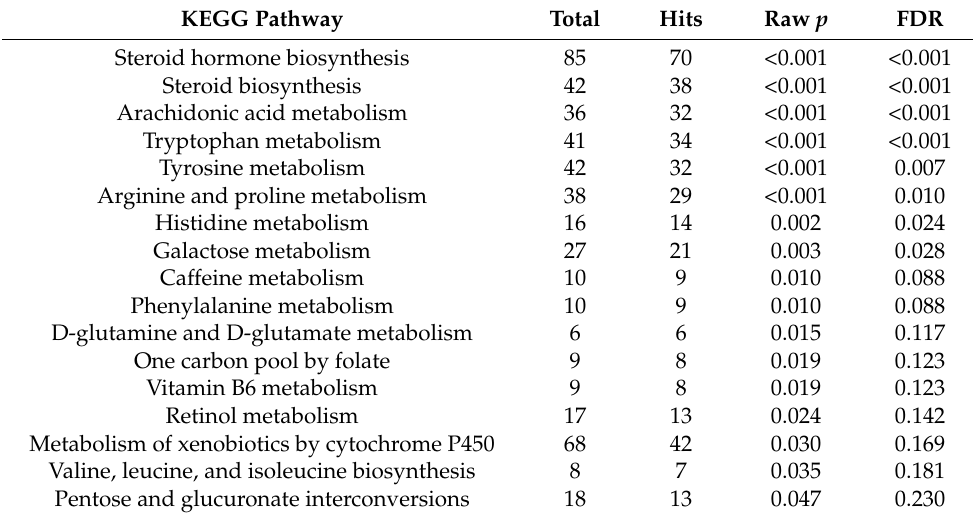
Table 3. Significant pathways hit with 793 unique KEGG IDs.